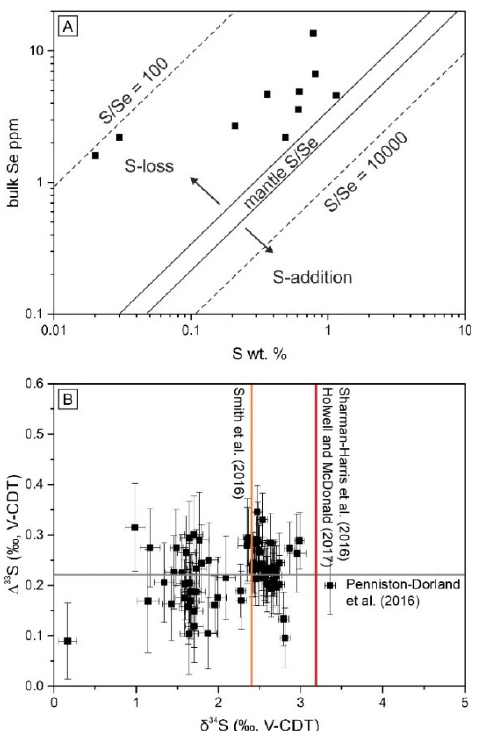
Figure 12. ( A ) Sulphur wt % vs. bulk Se (ppm) from samples with S contents associated with substantial amounts of mineralization; ( B ) Sulphur isotope compositions of measured pyrrhotite and pentlandite. The grey line represents the Δ 33 S range of the pristine magma, whereas the orange and red lines represent the δ 34 S range of the pristine magma. Error bars are 1 σ [16,75,77,78].